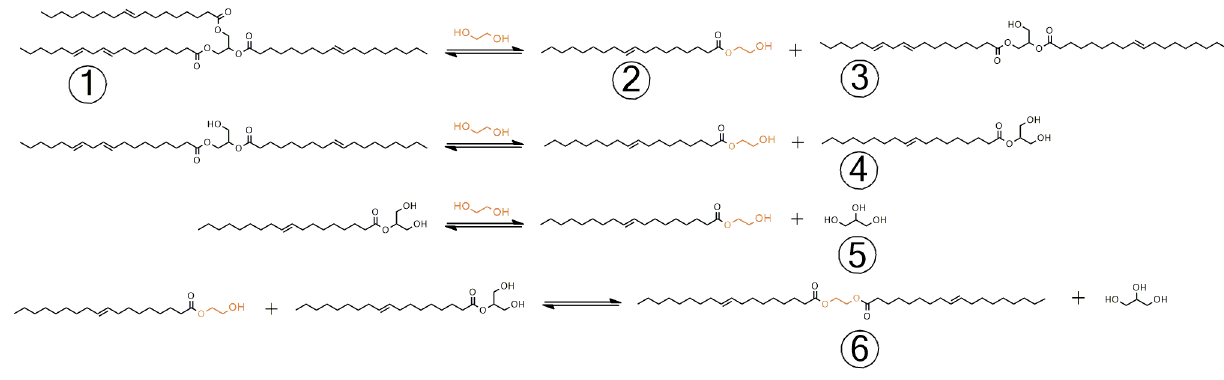
Figure 2. Transesterification course and the reaction products: 1 — triglyceride, 2 — ethylene glycol monoester, 3 — diglyceride, 4 — monoglyceride, 5 — glycerol and 6 — ethylene glycol diester.